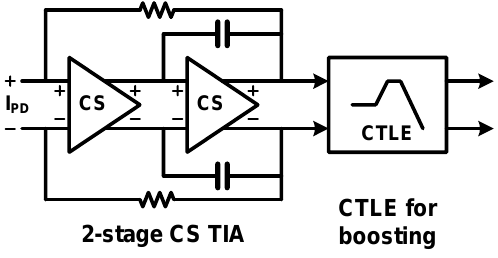
Figure 38. Overall structure of [91].